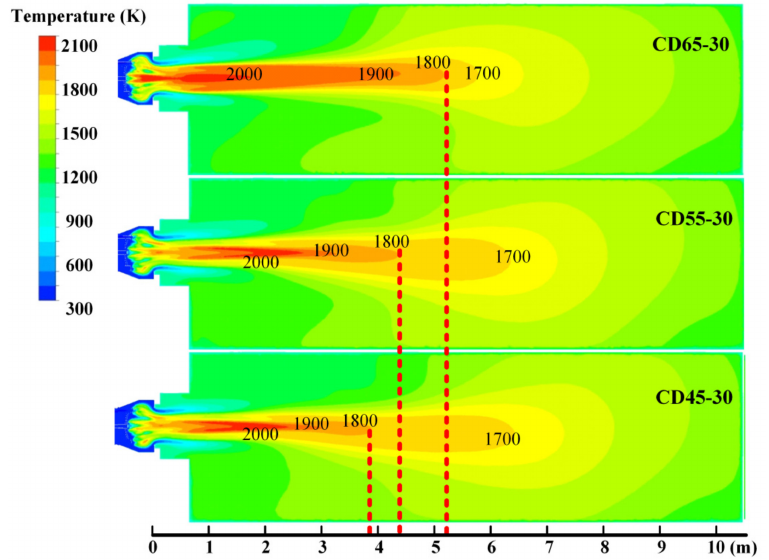
Figure 14. Temperature distribution of CD65-30, CD55-30, and CD45-30 in the center cross